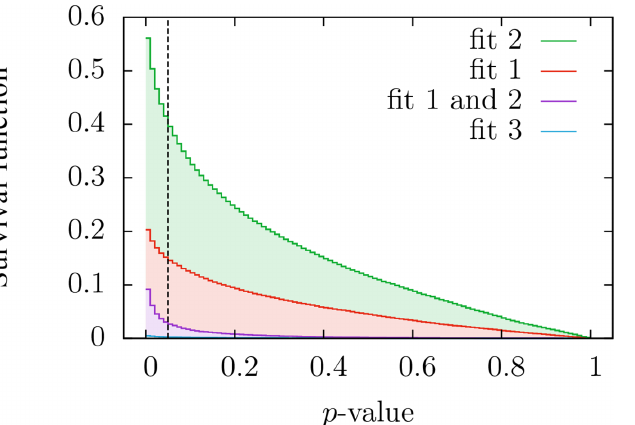
Fig 3. Complementary cumulative distributions (i.e., survival functions) of p -values obtained when our three distributions are fitted to the texts of the English Project Gutenberg. This corresponds, except for normalization, to the integral of the previous figure, but we have included a fourth curve for the fraction of texts whose p -values for fits 1 and 2 are both higher than the value marked in the abscissa. Note that the values of p can play the role of the significance level. The value for p = 0 is not shown, in order to have higher